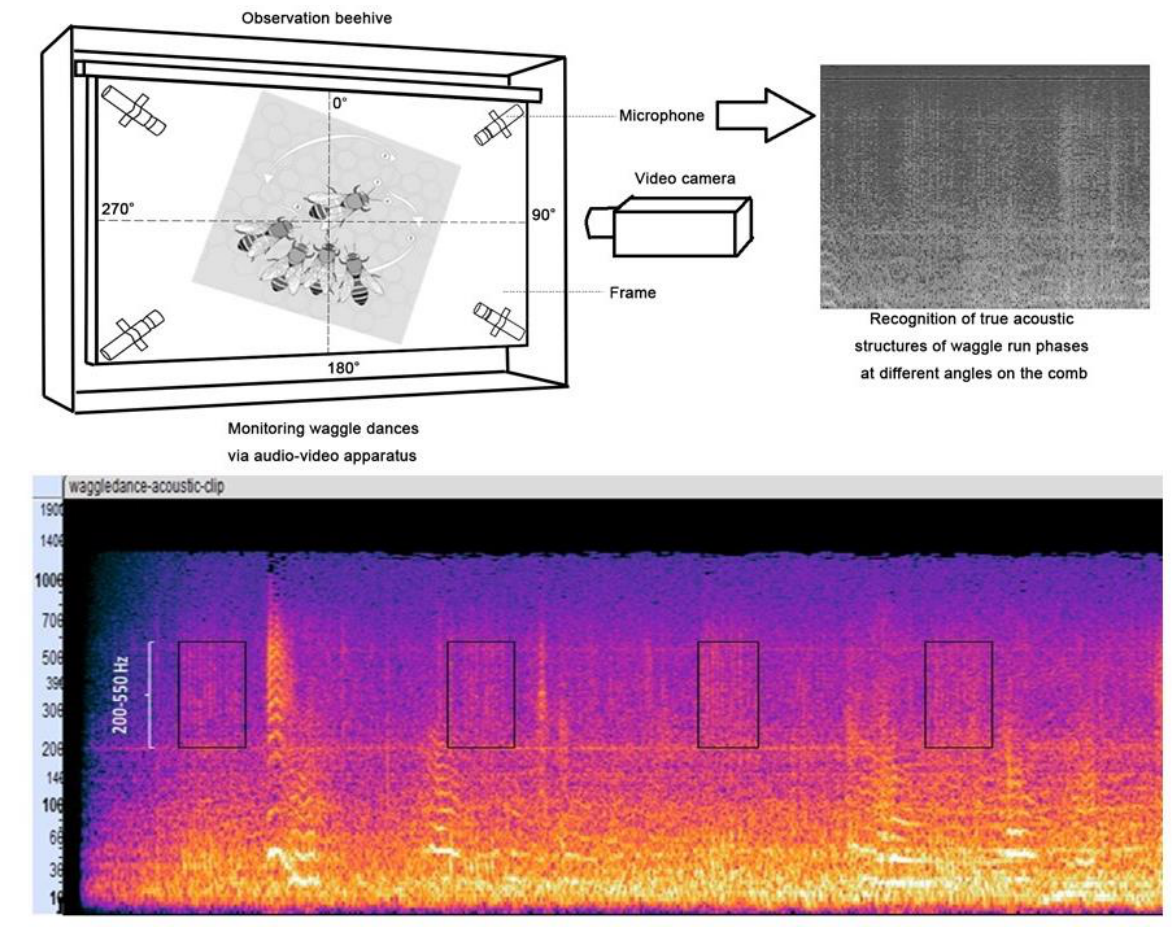
Figure 6. Our proposed setup is where waggle dancers are recorded in an observation beehive through audio-video monitoring for the bursting sound they produce during the waggle-run phase and their dancing angels on the comb relative to the position of the microphone (left), plus recognition of the true acoustic structures produced from these dances (right). Below is a view of the acoustic structure of the waggle-run phase of a dancing bee (from the Apis mellifera colony) in the form of a spectrogram (see the spectral composition of the waggle-run phase in the black-colored vertical boxes, which display frequencies between 200 and 550 Hz).